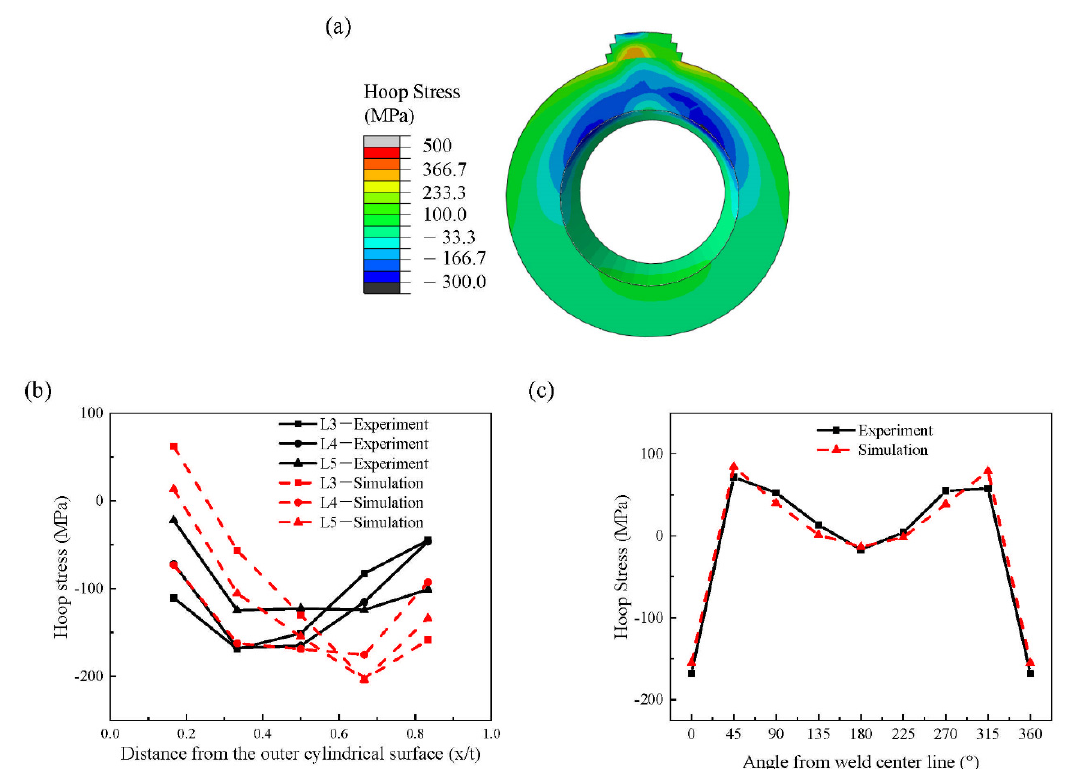
Figure 9. ( a ) Hoop stress distribution on the cross section at mid-length of the weld overlay joint, ( b ) comparison of hoop residual stress on the area of interest, ( c ) comparison of hoop residual stress on the whole tube.